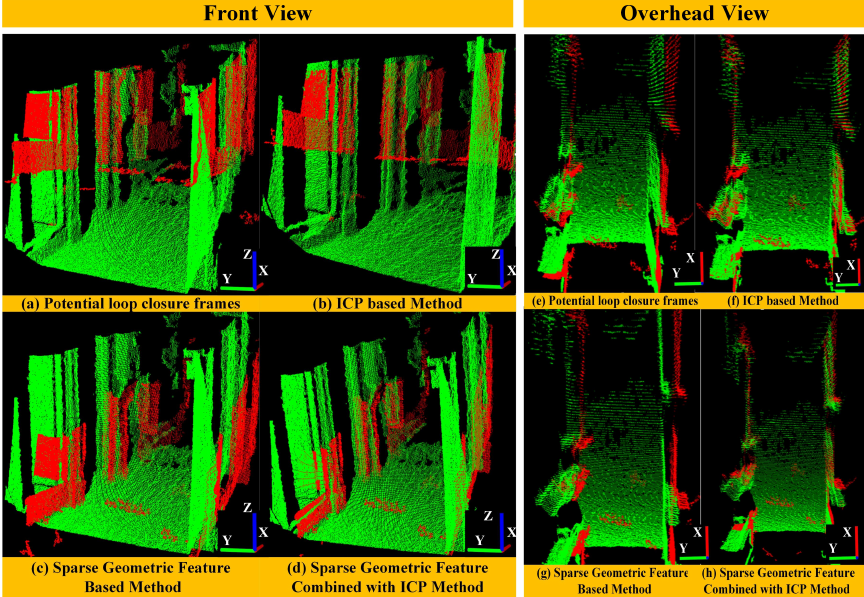
Figure 9. The performance of matched potential loop closure frames after applying different kinds of methods shown in the front and overhead view (The green point cloud has floor constraints, while the red point cloud does not).